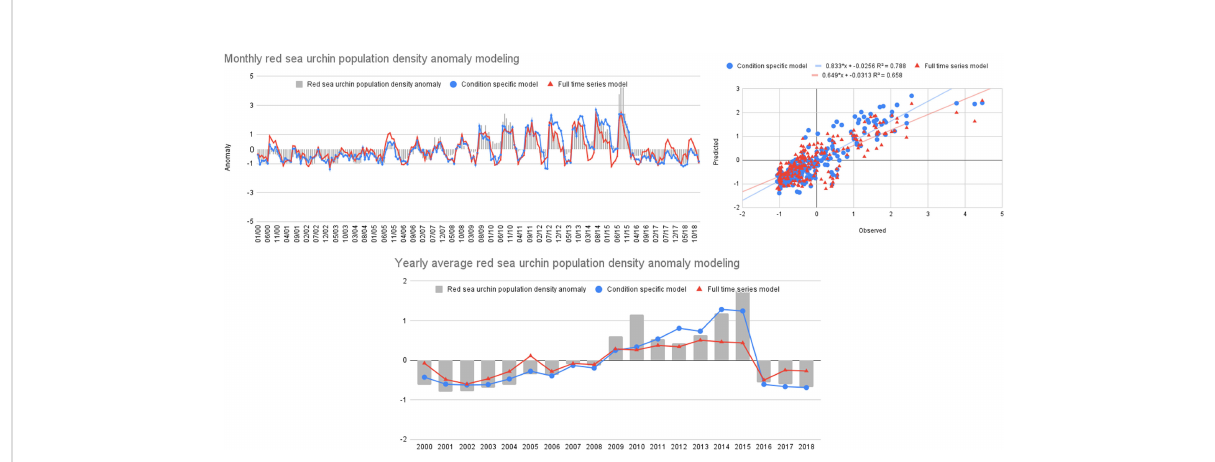
FIGURE 9 Comparison between observed density of red sea urchin population anomaly (bars), and predicted values from full-time series ( ▲ ) and Condition-speci fi c ( (cid:129) )